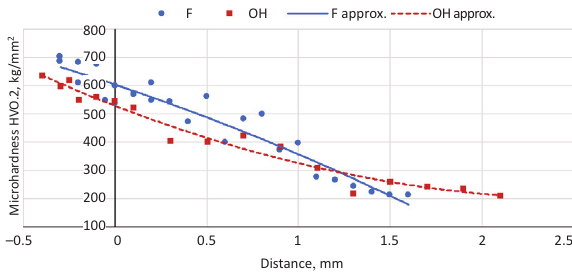
Fig. 6. Vertical microhardness measurements at α = 36°.